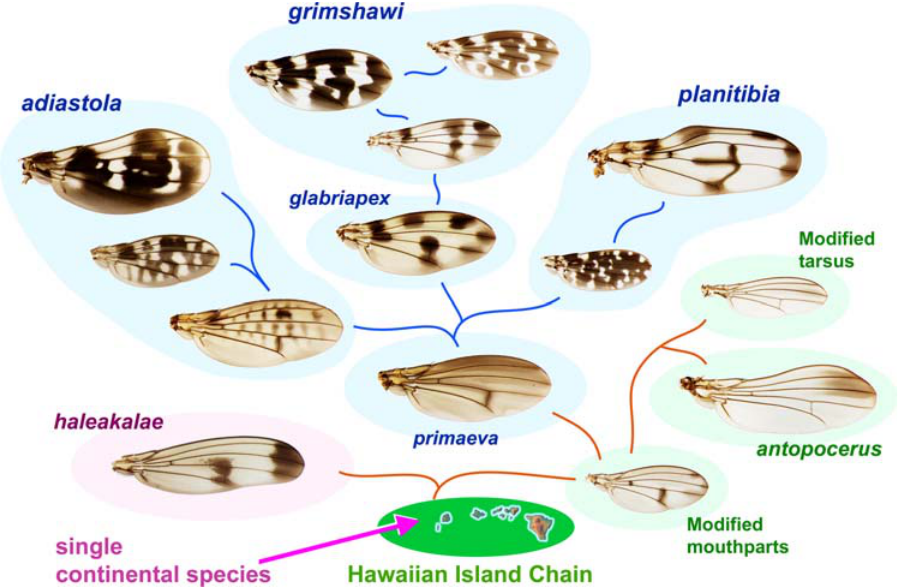
Figure 1. Overview of relationships among major species groups and picture wing subgroups . Schematic based on chromosomal inversions, DNA sequence data, and morphology [1,4,40,41]. Arrow indicates the proposed single introduction of Drosophila to an island west of Kauai. Blue backgrounds, picture wing subgroups; green backgrounds, modified mouthparts, modified tarsus, and antopocerus groups; pink background, haleakalae /fungus feeder group. Lines schematically indicate consensus phylogenetic relationships. Examples of increasing pattern complexity in the adiastola and grimshawi subgroups are shown. See Figs. 2–7 for species names. Hawaii map courtesy of geology.com and mapresources.com.